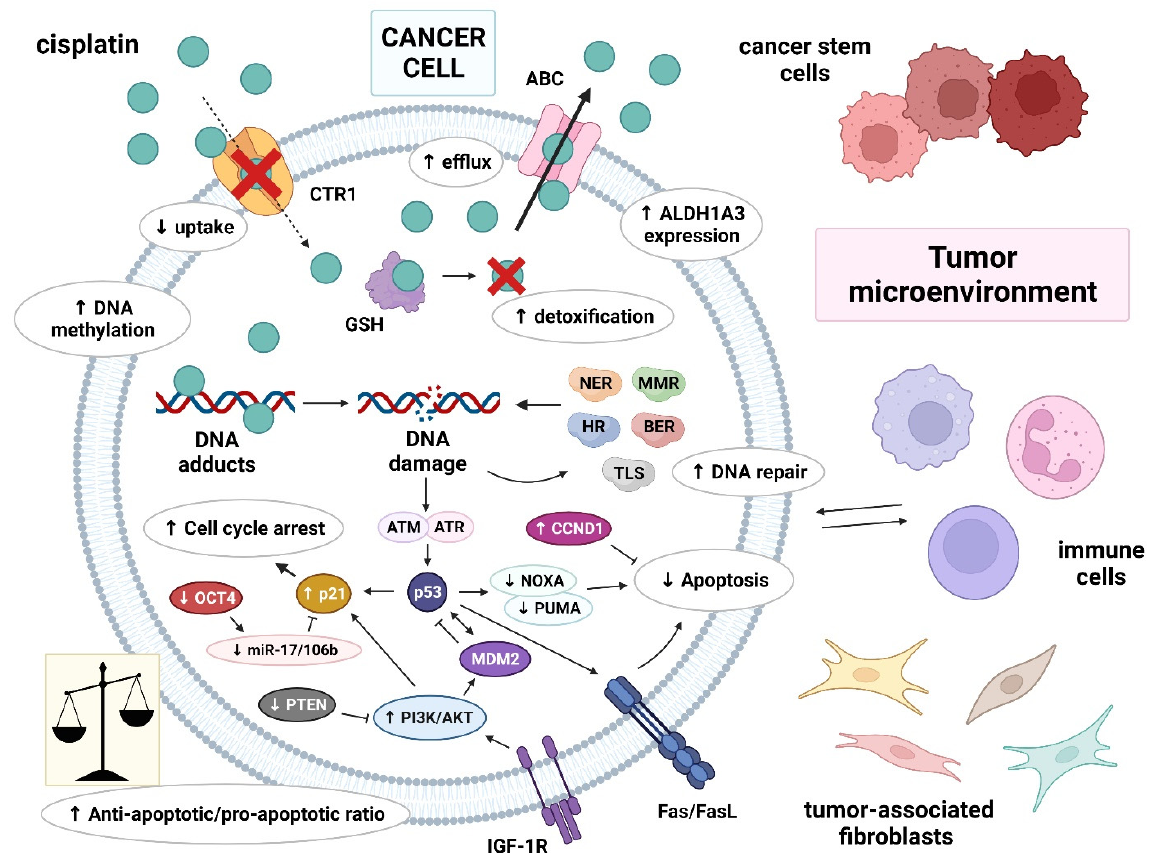
Figure 1. Multiple molecular mechanisms are responsible for cisplatin resistance in germ cell tumors. Cisplatin resistance can be classified as pre-target, on-target and post-target. Pre-target resistance includes: decreased intracellular accumulation of cisplatin (reduced uptake and increased efflux of cisplatin) and increased cisplatin detoxification by cytoplasmic scavengers. On-target resistance refers to an increased ability to repair DNA damage or an acquired ability to tolerate unrepaired DNA lesions. Post-target resistance involves: alterations in apoptosis signaling pathways with a central role of p53, decreased expression of pro-apoptotic factors, and overexpression of anti-apoptotic factors. This leads to cell cycle arrest and the inhibition of apoptosis. Other factors that contribute to cisplatin resistance are: DNA hypermethylation, increased ALDH expression, and a tumor microenvironment with immune cells playing an important role. Abbreviations: ABC = ATP-binding cassette trans- porter; AKT = protein kinase B (PKB); ALDH1A3 = aldehyde dehydrogenase 1A3; ATM = ataxia telangiectasia mutated; ATR = ATM and RAD3-related; BER = base excision repair; CCND1 =